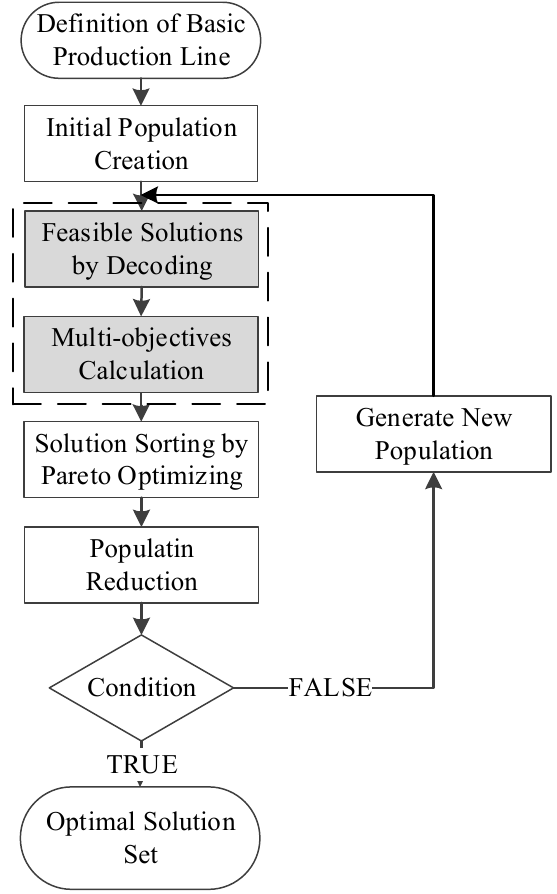
Figure 2. Logic diagram of the complete approach.